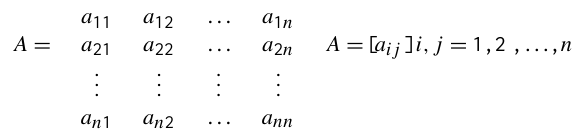
Table 3. Pairwise comparisons